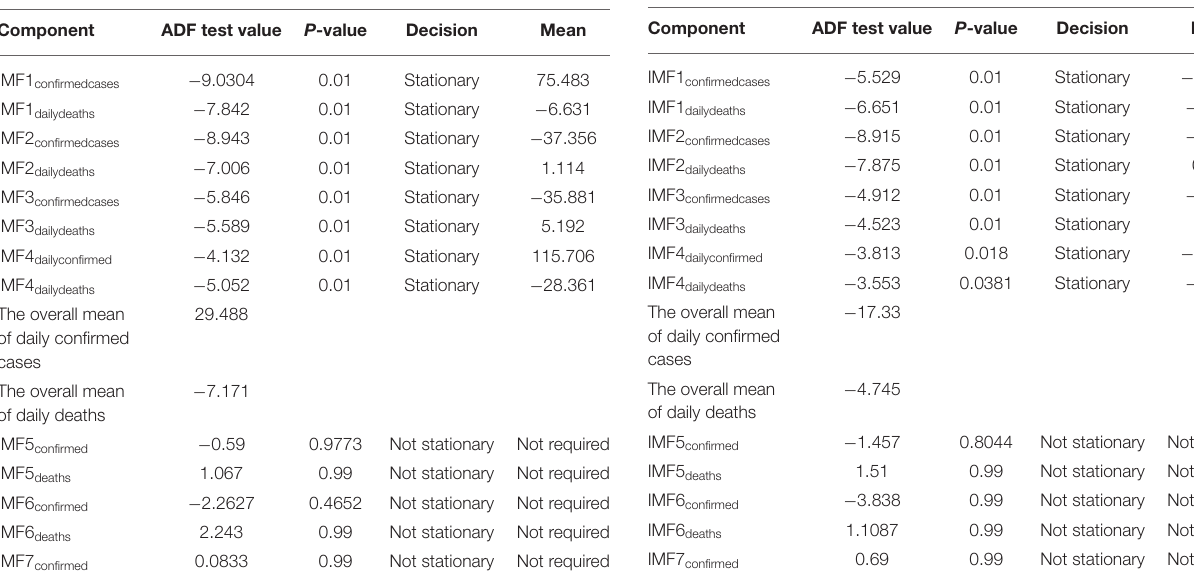
TABLE 4 | ADF test results along with the overall mean for